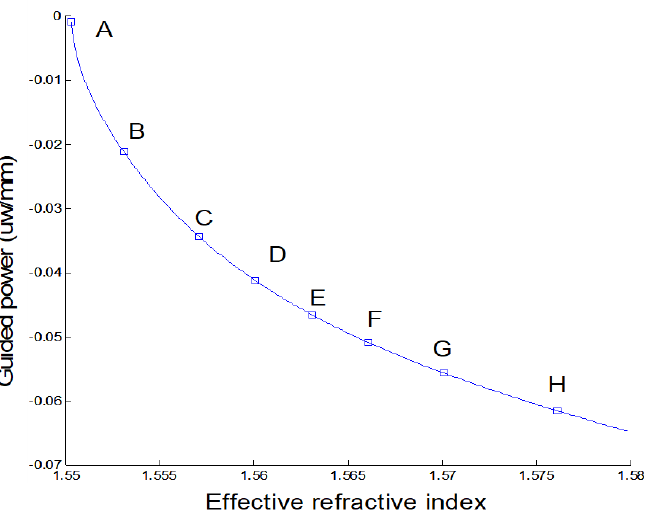
Figure 6. Dispersion curve of five-layer metamaterial waveguide with nonlinear cladding and substrate at d f = 2 µ m and d i = 6 µ m.